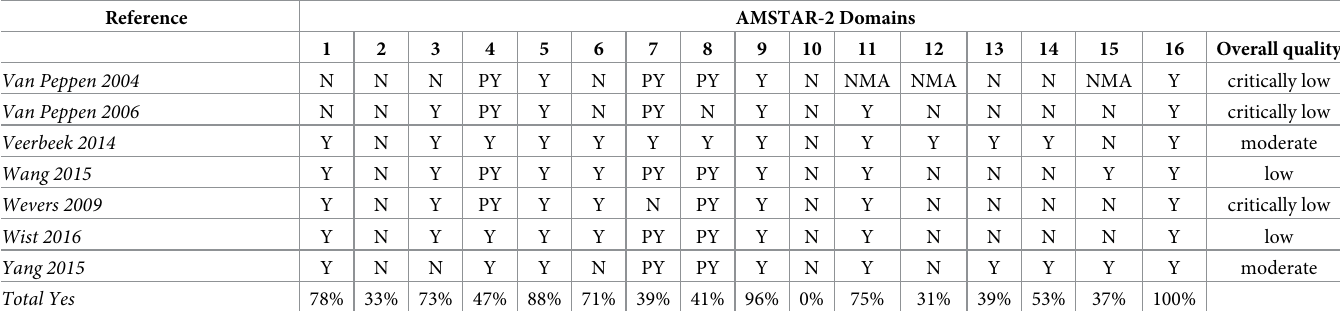
(766 participants), reported a statistically significant improvement of repetitive task training, with low quality of evidence. Saunders 2016 [25] CSR, based on 19 trials (1128 participants), reported significant beneficial effects of resistance training and mixed training and no effect of cardiorespi- ratory training, with high quality of evidence for all comparison with balance outcomes. Vloothuis 2016 [27] CSR, based on 3 trials (139 participants), reported significant improve- ment of care-mediated exercise in addition to usual care, with low quality of evidence for bal- ance in caregiver-mediated exercises compared with control intervention. Lawrence 2017 [28] CSR, with 2 trials (69 participants), and Mehrholz 2011 [29] CSR, with 2 trials (38 participants), reported no significant effect of yoga and water-based exercises, respectively, with very low quality of evidence. English 2017 [30] CSR, based on 11 trials (935 participants), reported significant beneficial effects of circuit class therapy with low quality of evidence. Systematic reviews with high methodological quality: Other interventions. Four CSRs evaluated the effectiveness of interventions for eye movement disorders and visual field defects [32,33], virtual reality [34] and cognitive rehabilitation [35] on outcome measures of balance. Pollock 2011a , b [32,33] CSR were not able to draw conclusions from their studies on balance outcomes because they found no studies. Laver 2017 [34] CSR, based on 13 trials (320 partici- pants), reported significant improvement of virtual reality combined with usual care, but no improvement when comparing virtual reality to conventional therapy. GRADE judgement quality was not reported for the balance outcomes. Bowen 2013 [35] CSR found no relevant outcome data for evaluating cognitive rehabilitation effects on balance. Systematic reviews with moderate methodological quality: Physical therapy. Eight moderate-quality reviews, 1 CSRs and 7 non-CSRs, evaluated the effect of exercise